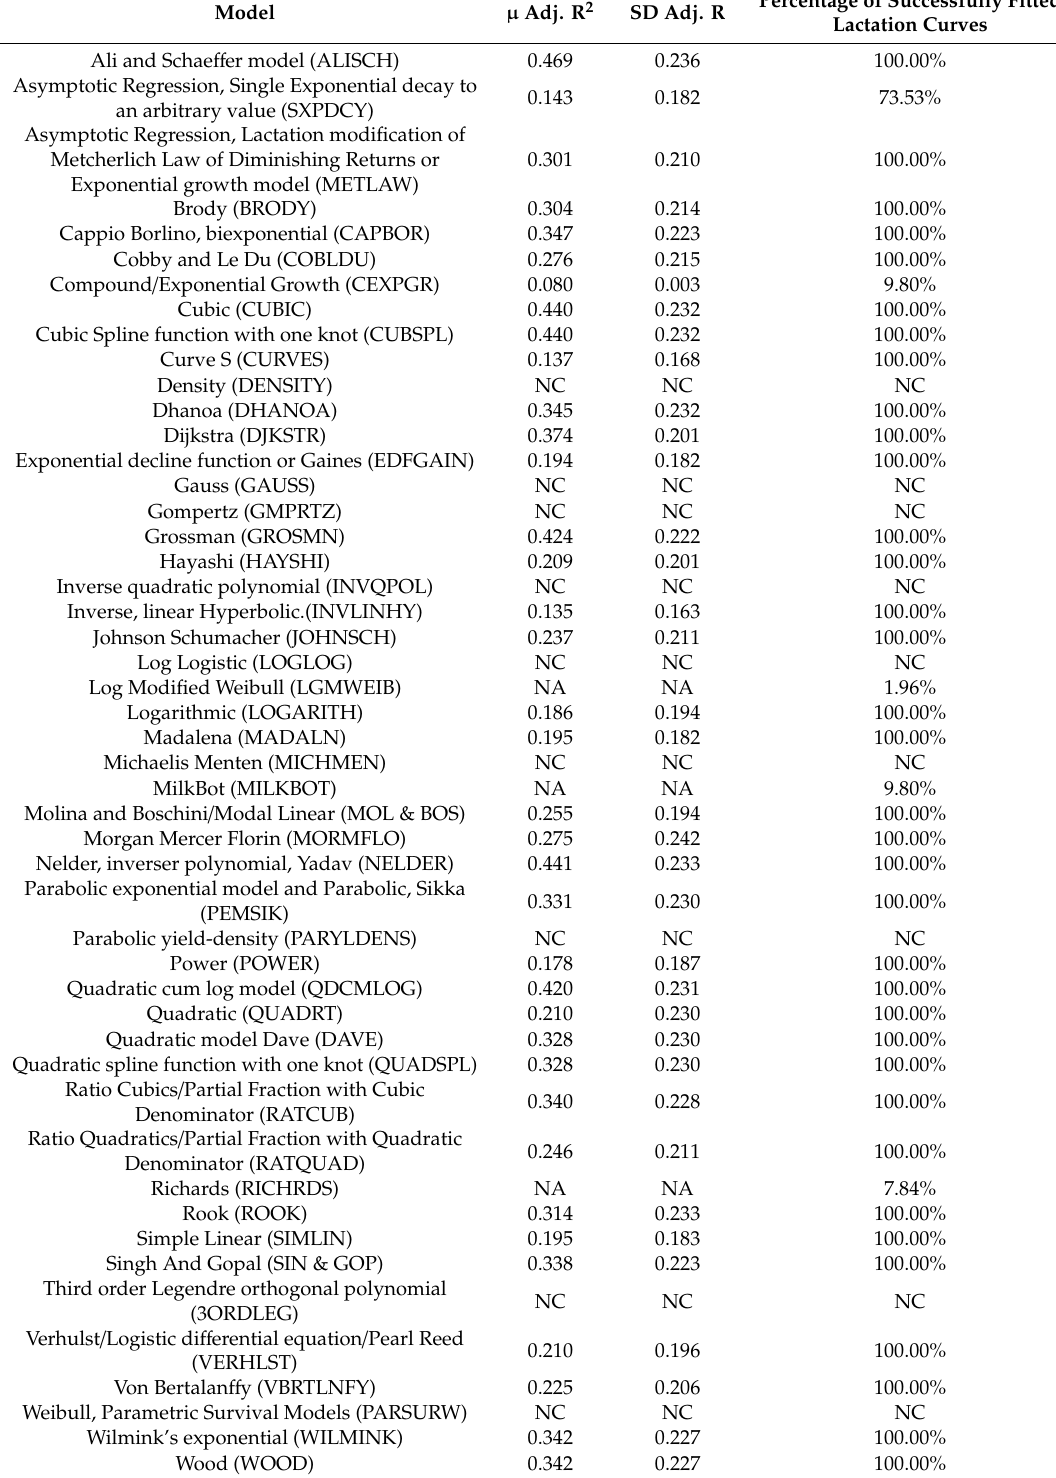
Table 2. Mean Adjusted coe ffi cient of determination (Adj. R 2 ), Adj. R 2 Standard deviations (SD) and percentage of successfully fitted lactation curves of the models of lactation curve for milk yield (Kg) in goat